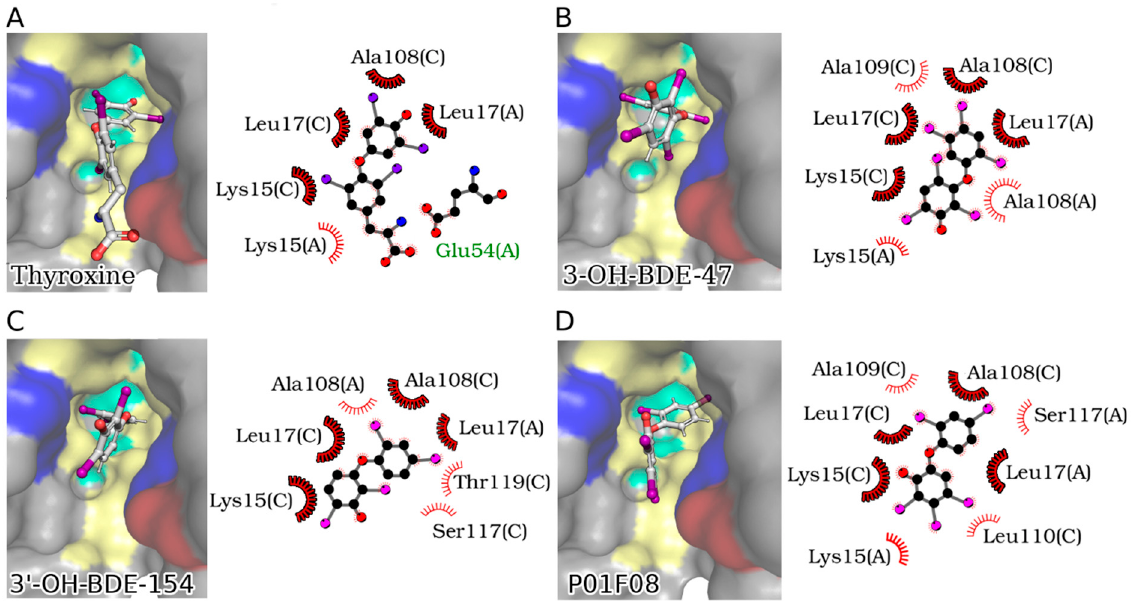
Figure 4. TTR-mediated thyrotoxicity of PBDEs. Crystal structure of TTR bound to T 4 (PDB ID: 5CR1) ( A ) and docked 3-OH-BDE-47 ( B ), 3 ′ -OH-BDE-154 ( C ), and P01F08 ( D ). For each figure, the left panel shows the accessible surface of the binding pocket. The hydrophobic surface is highlighted in yellow, the polar in cyan, the positively charged in blue, and the negatively charged in red. The right panel shows a schematic 2D representation of the interactions between the ligand and the residues of the binding pocket. Carbon, nitrogen, oxygen, iodine, and bromine atoms are represented in black, blue, red, purple, and magenta, respectively. Single-letter chain identifiers are present next to each residue. Hydrophobic contacts are shown as red splines curves. Hydrophobic contact common for all ligands are highlighted in bold.